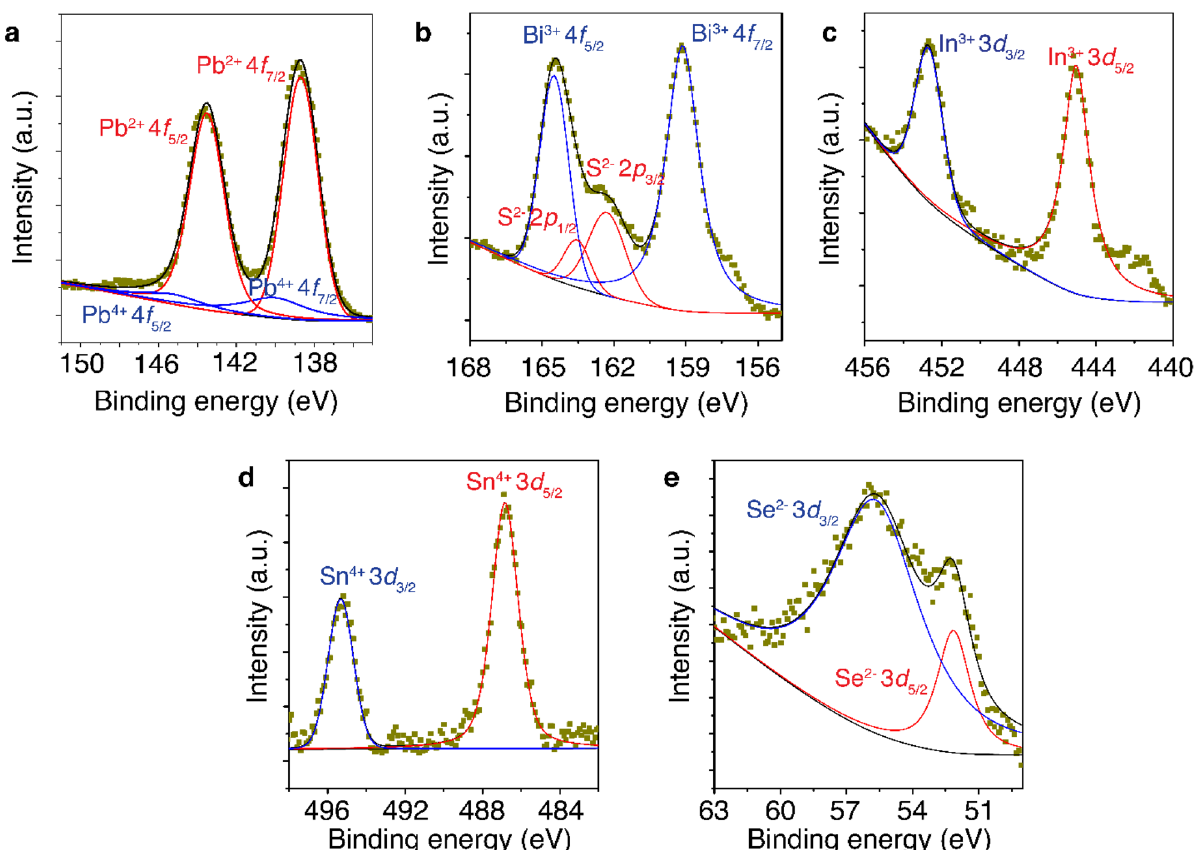
Figure 2. High-resolution XPS spectra around the binding energy regions of main elements in abramovite ( a ) Pb 4 f , ( b ) Bi 4 f and S 2 p , ( c ) In 3 d , ( d ) Sn 3 d , and ( e ) Se 3 d